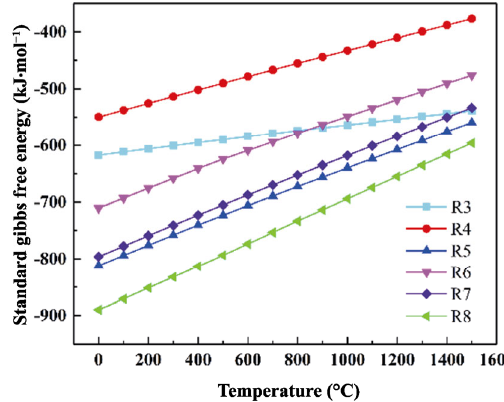
Fig. 16 Standard Gibbs free energy of possible reactions mentioned